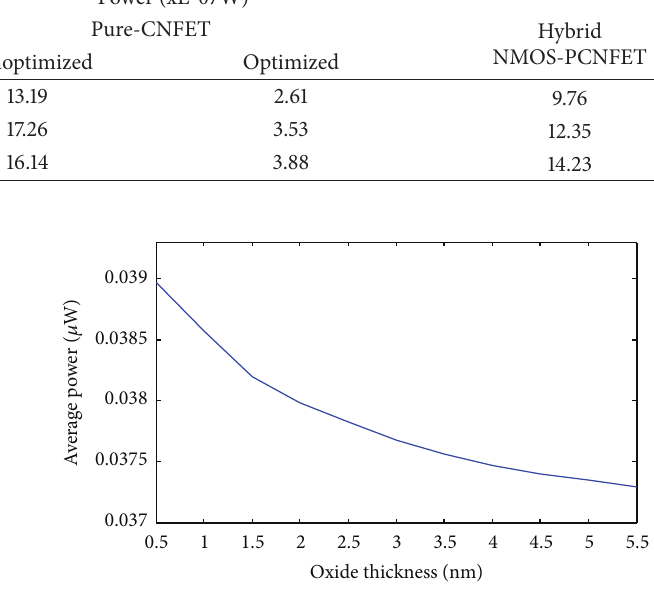
Figure 16: The gate parasitic capacitance with oxide thickness.